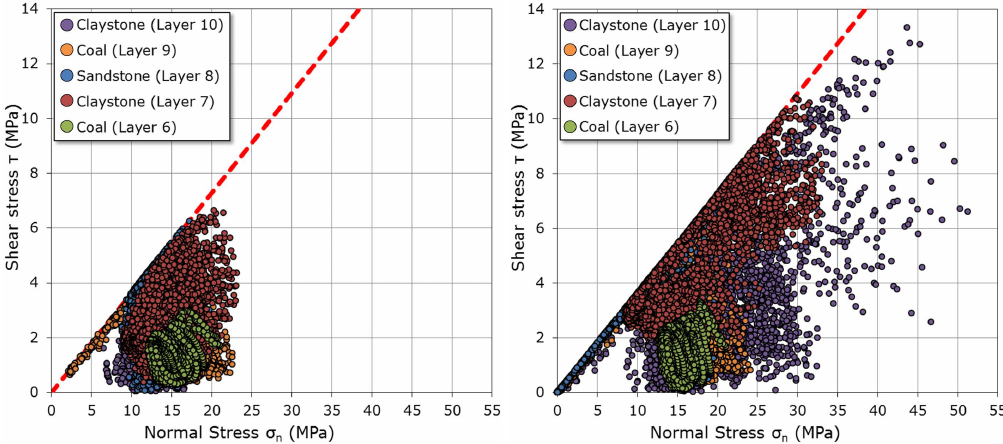
Figure 7. Normal versus shear stress plots for the fault elements in: isothermal simulation ( left ); and non-isothermal simulation ( right ) at end of the operational time. Coulomb failure line plotted as dashed red